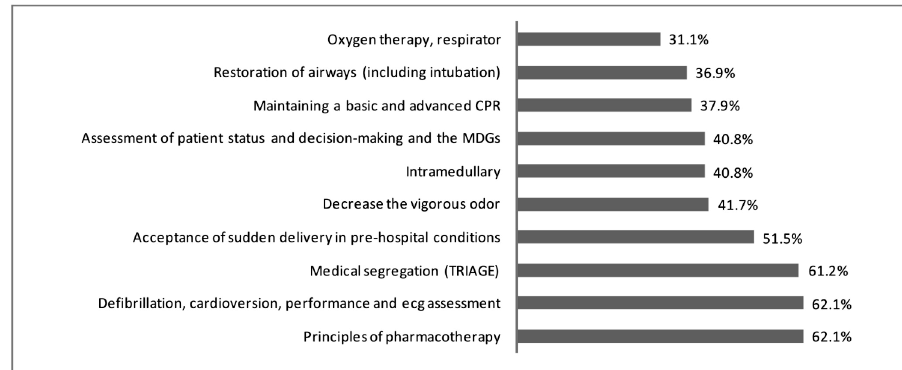
Figure 6. Topic ranges, according to paramedics’ interests, as part of professional development (number of respondents in